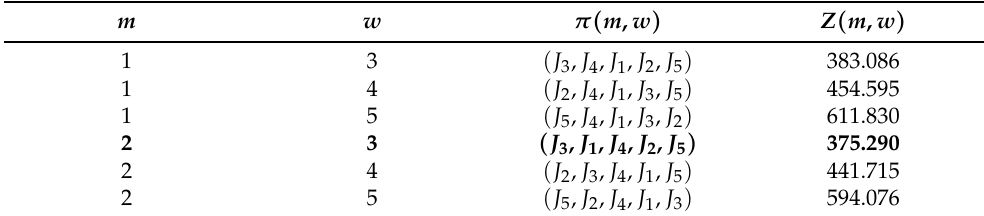
Table 6. Results of problem P 3 (bold numbers are the optimal solution).